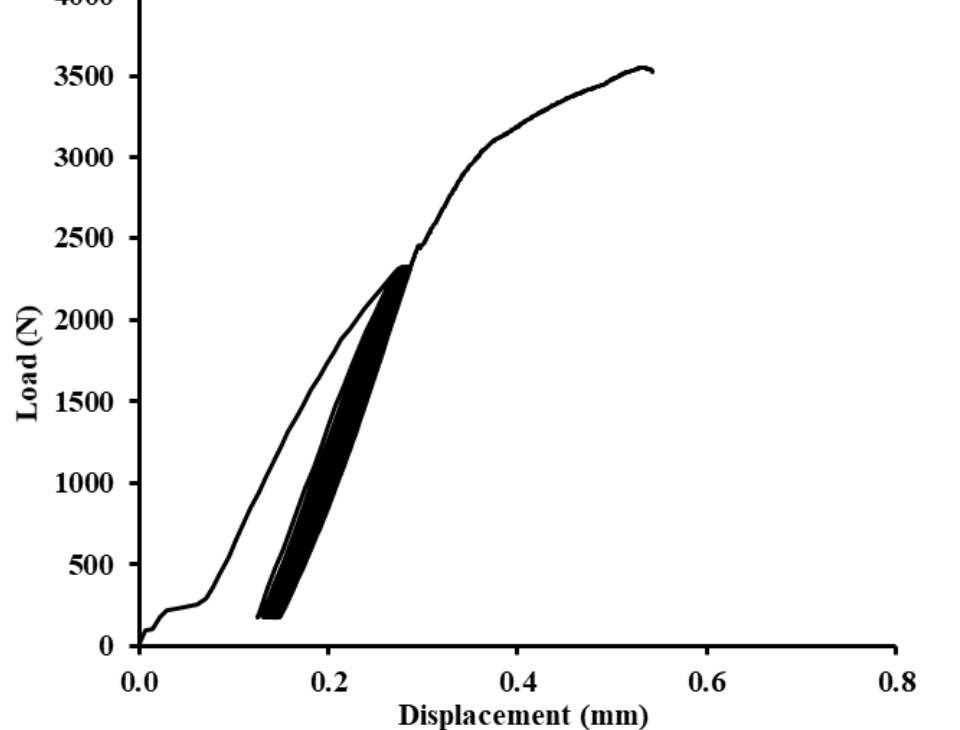
Figure 13. Quasi-static graph of adhesive bond ABFE1 with loading 5–70% (165–2307 N)—734 cycles.